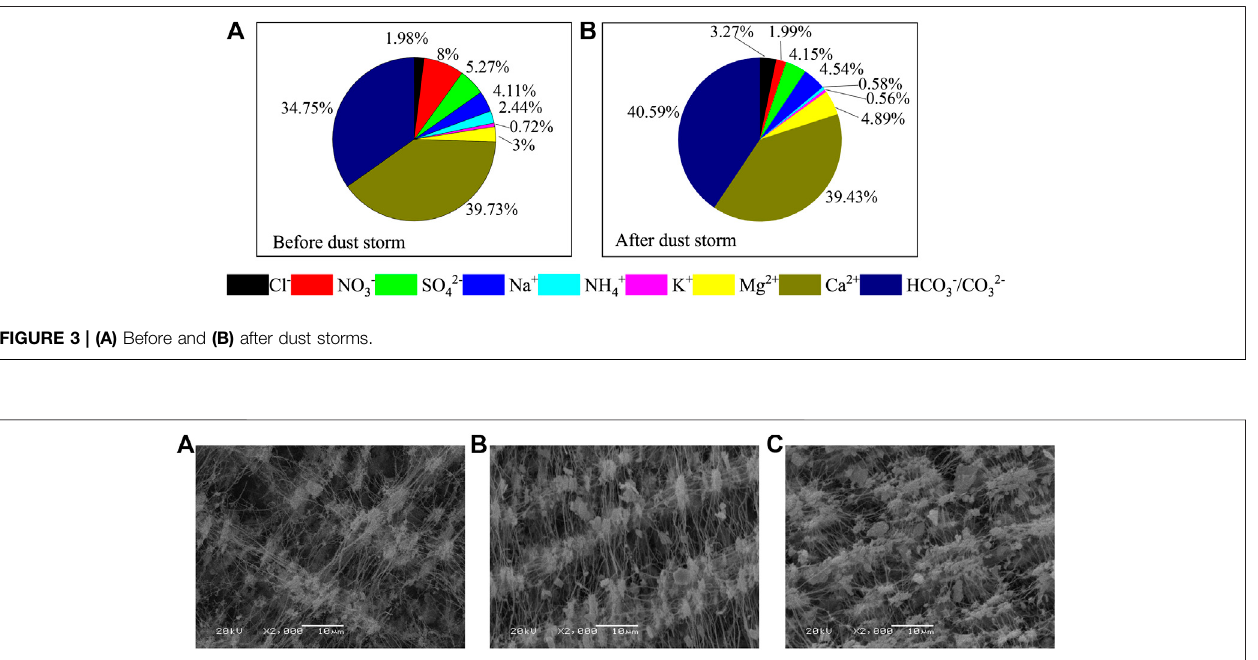
Frontiers in Earth Science |